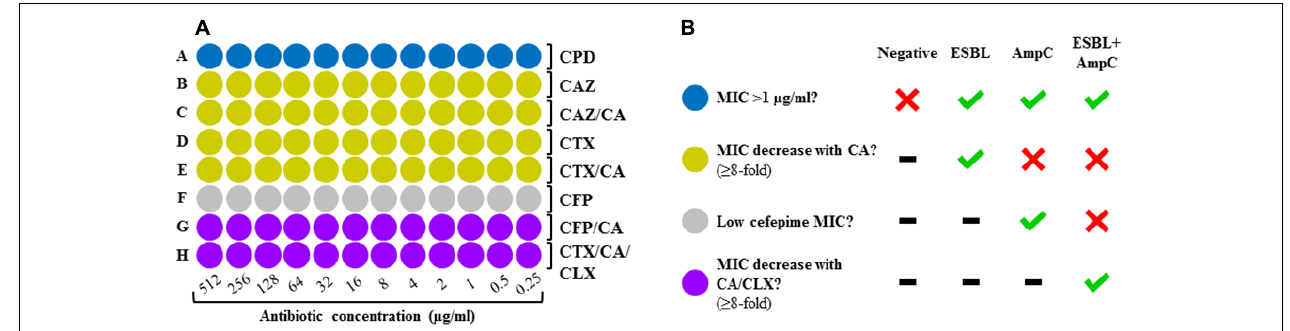
FIGURE 1 | (A) Layout of the DOT-MGA screening panel. Blue zone, resistance screening; yellow zone, detection of ESBL; gray zone, detection of AmpC; purple zone, detection of ESBL + AmpC. CPD, cefpodoxime; CAZ, ceftazidime; CTX, cefotaxime; CFP, cefepime; CA, clavulanic acid; CLX, cloxacillin. (B) Interpretation of results according to EUCAST’s diagnostic